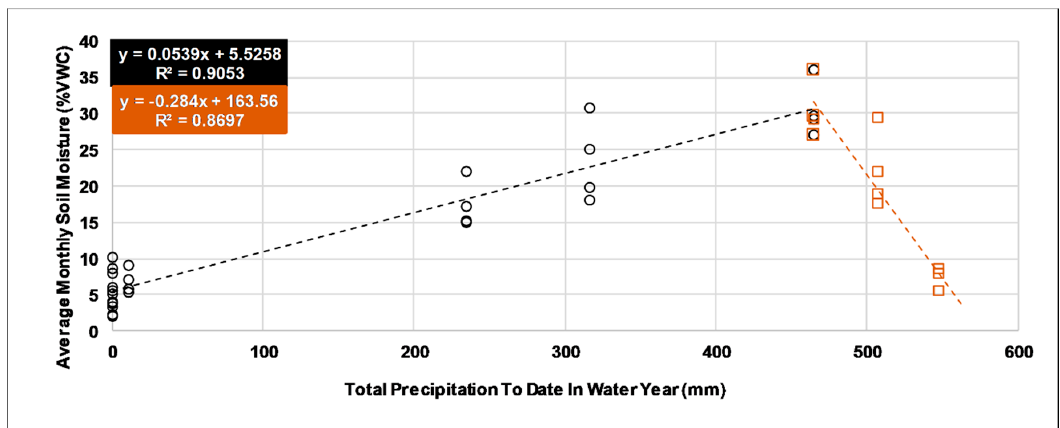
Figure 4. Linear regression analysis of all sites during water year 2019 for average soil moisture (%VWC) and total precipitation to date (mm). The open black circles represent measurements from 0 mm of precipitation until the average soil moisture peaked in March 2019 at 465 mm of total precipitation in water year 2019 (wet season). The brown squares represent measurements from the peak average soil moisture until the end of the water year 2019 where the total precipitation was 548 mm (dry season).